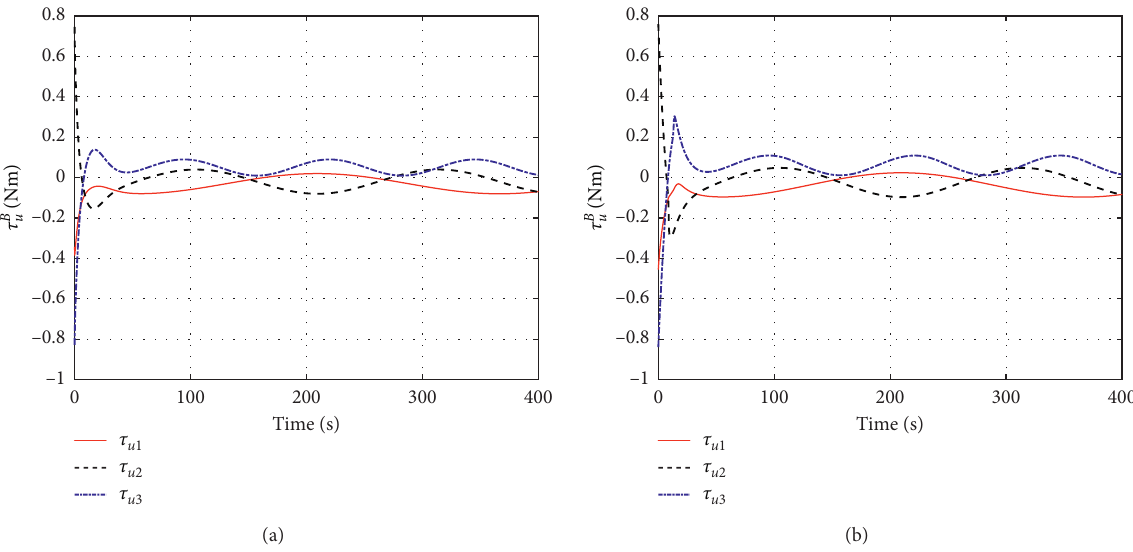
Figure 14: Control torque. (a) Proposed I&I adaptive controller. (b) SMC.